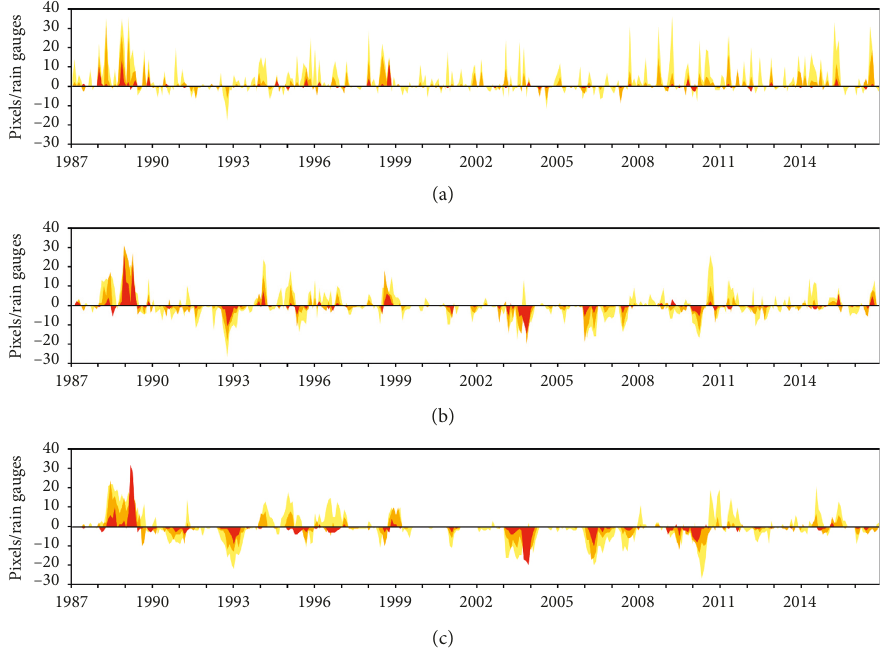
Figure 9: Temporal evolution of the difference between the number of CHIRPS pixels and the number of rain gauges with dry conditions for the different dry categories and timescales: (a) SPI1, (b) SPI3, and (c)